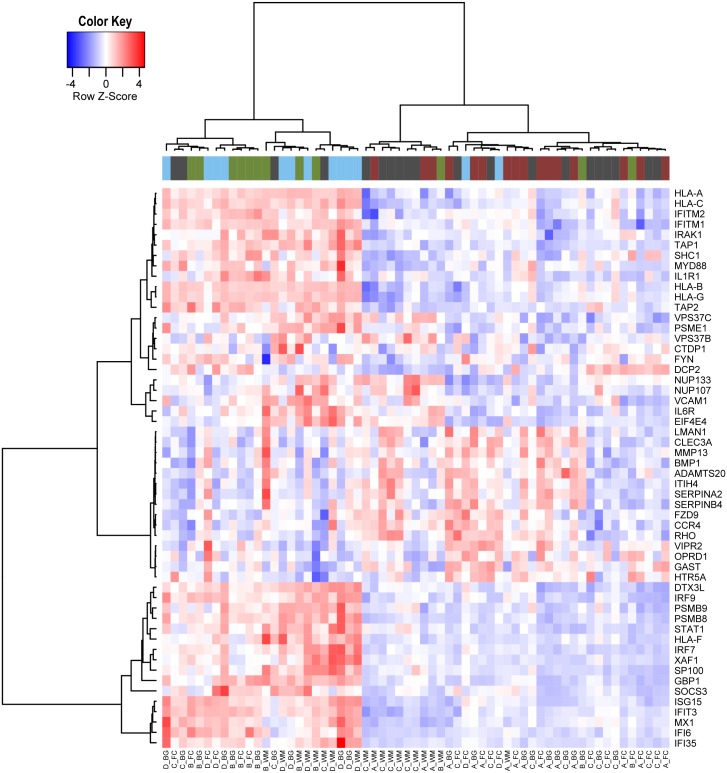
Genes differentially expressed in HIV-infected patients without NCI.The heatmap shows the genes in the leading edge of the pathways commonly dysregulated in all 3 brain regions in HIV-infected patients without NCI as compared to uninfected controls. We selected the 54 genes most differentially expressed (t-test, p-value < 0.01) among the list of 128 genes belonging to the leading edges of the significant pathways identified by the GSEA analysis in HIV-infected patients without NCI in comparison with uninfected controls.